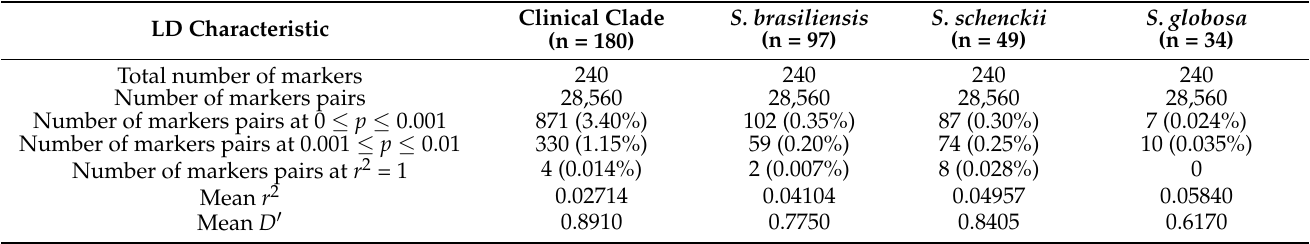
Table 5. Linkage disequilibrium ( LD ) analysis in the complete Sporothrix isolate set (n = 180) and within members of the clinical